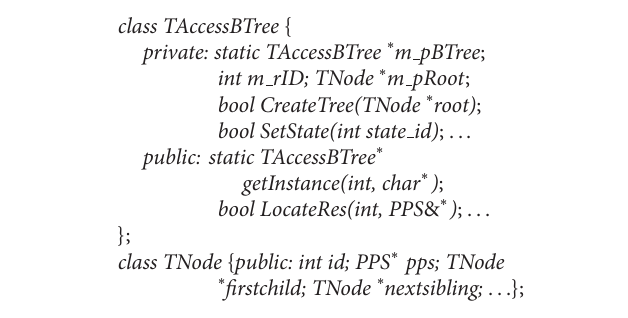
Algorithm 2: Basic classes for the TPSAC